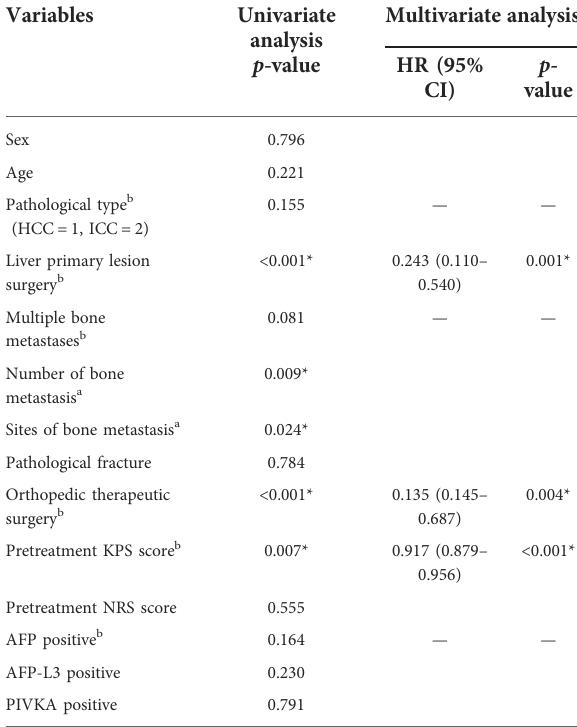
TABLE 3 Cox regression analysis to identify the prognostic factors of survival time.